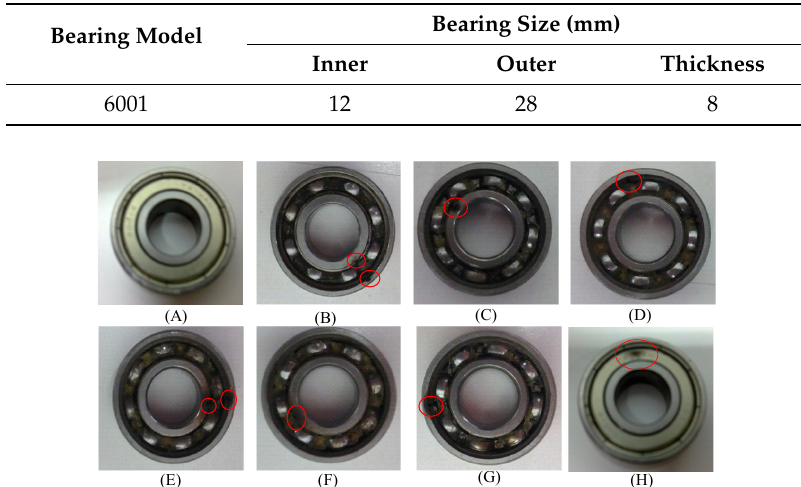
Figure 6. ( A ) Healthy bearing, ( B ) 1.0 mm holes on both inner and outer race, ( C ) one 1.0 mm hole on